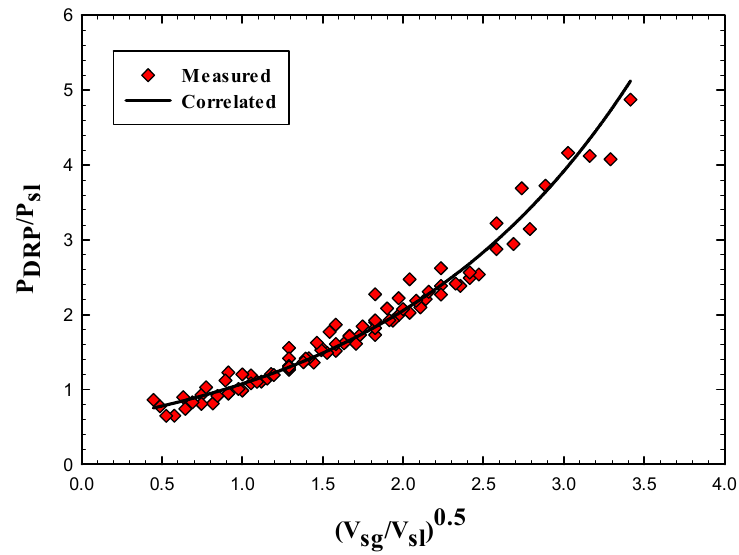
Figure 18. Dimensionless pressure drop ratio versus square root of the normalized superficial velocities (correlation is Equation (11)).